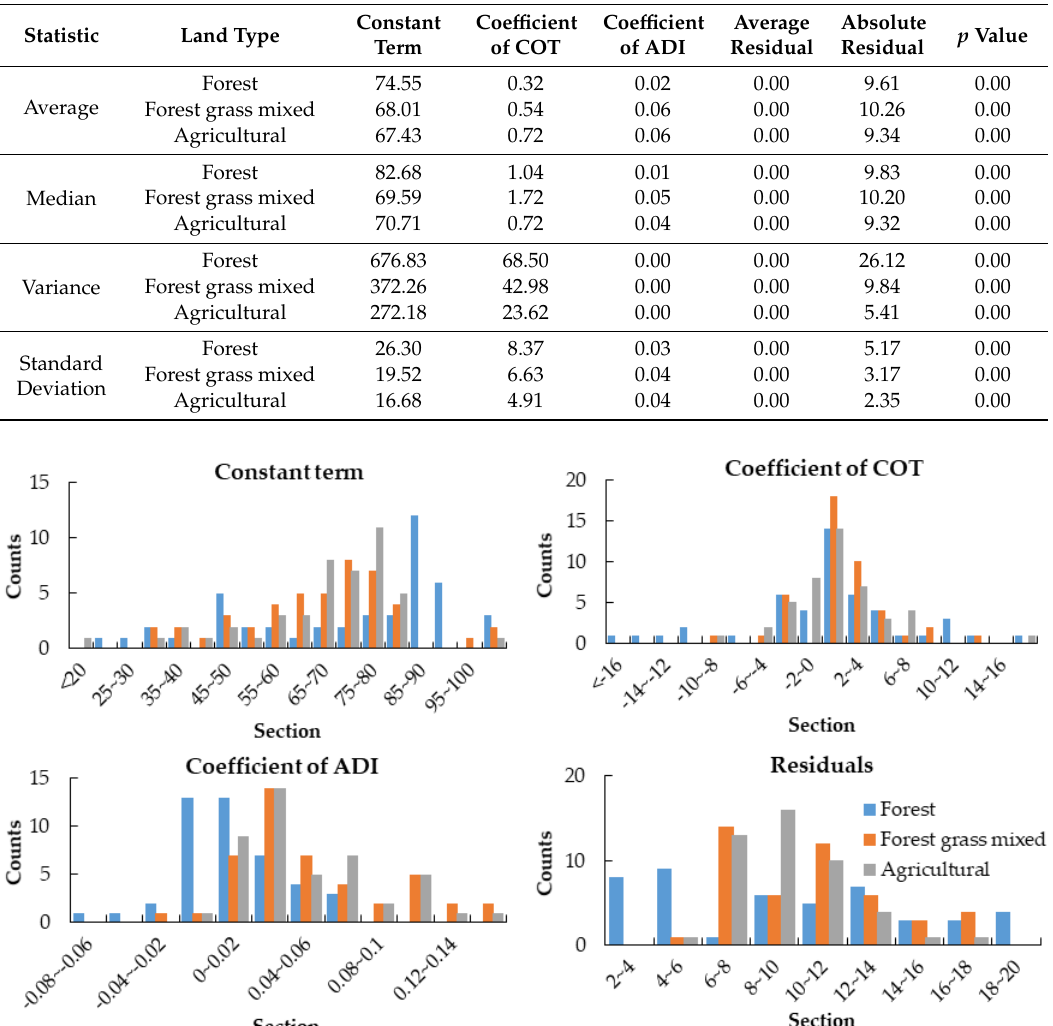
Table 2. Comparison of parameters of di ff erent land cover types in 2016.